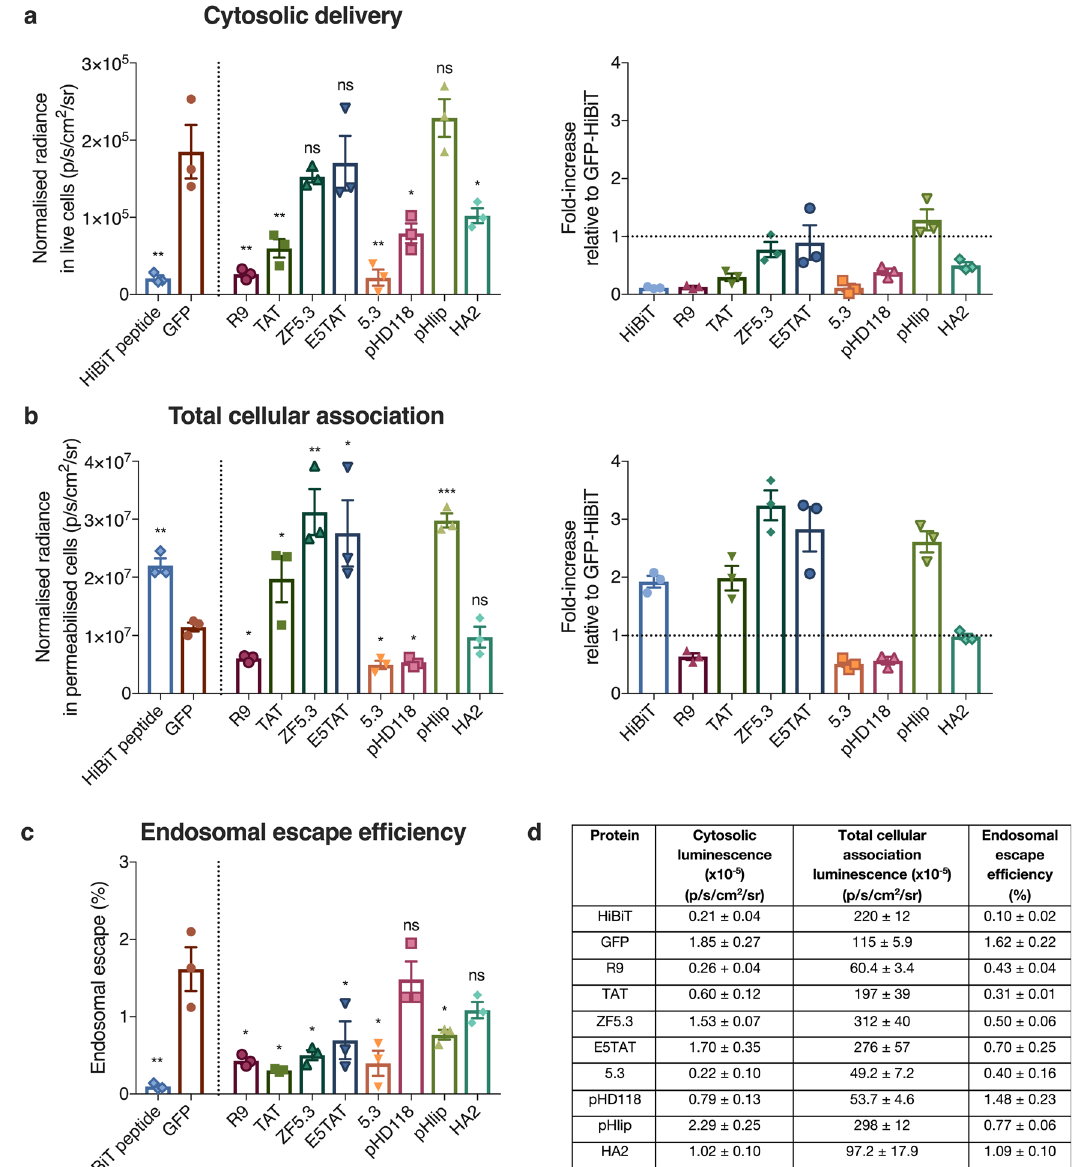
Fig. 6 EEPs do not increase endosomal escape ef fi ciency of GFP. a Cytosolic luminescent signal of EEP-GFP-HiBiT in HEK293-LSA cells and fold-increase in signal with respect to GFP (represented by dotted line = 1). HEK293-LSA cells were incubated with EEP-GFP-HiBiT proteins at varying concentrations (refer to methods) for 4 h. Data represents mean ± SEM, n = 3 independent experiments. Kruskal – Wallis with uncorrected Dunn ’ s test was used to analyse the data. b Total cellular association of EEP-GFP-HiBiT in HEK293 cells and fold-increase with respect to GFP-HiBiT (represented by dotted line = 1) determined by permeabilising the cells using 0.01% w/v digitonin. Data represents mean ± SEM, n = 3 independent experiments. Kruskal – Wallis with uncorrected Dunn ’ s test was used to analyse the data. c Endosomal escape ef fi ciency of EEP-GFP-HiBiT proteins determined by ratioing cytosolic signal with total cellular association. Data represents mean ± SEM, n = 3 independent experiments. Kruskal – Wallis with uncorrected Dunn ’ s test was used to analyse the data. d Summary of cytosolic luminescence, total cellular association luminescence and endosomal escape ef fi ciency for all proteins. Data represents mean ± SEM, n = 3 independent experiments. Kruskal – Wallis with uncorrected Dunn ’ s test was used to analyse the data, with GFP as the control group. Data represents mean ± SEM, n = 3 independent experiments. ns (not signi fi cant) denotes p > 0.05, * p ≤ 0.05, ** p ≤ 0.01 and *** p ≤ 0.001. Source data are provided as a Source Data fi